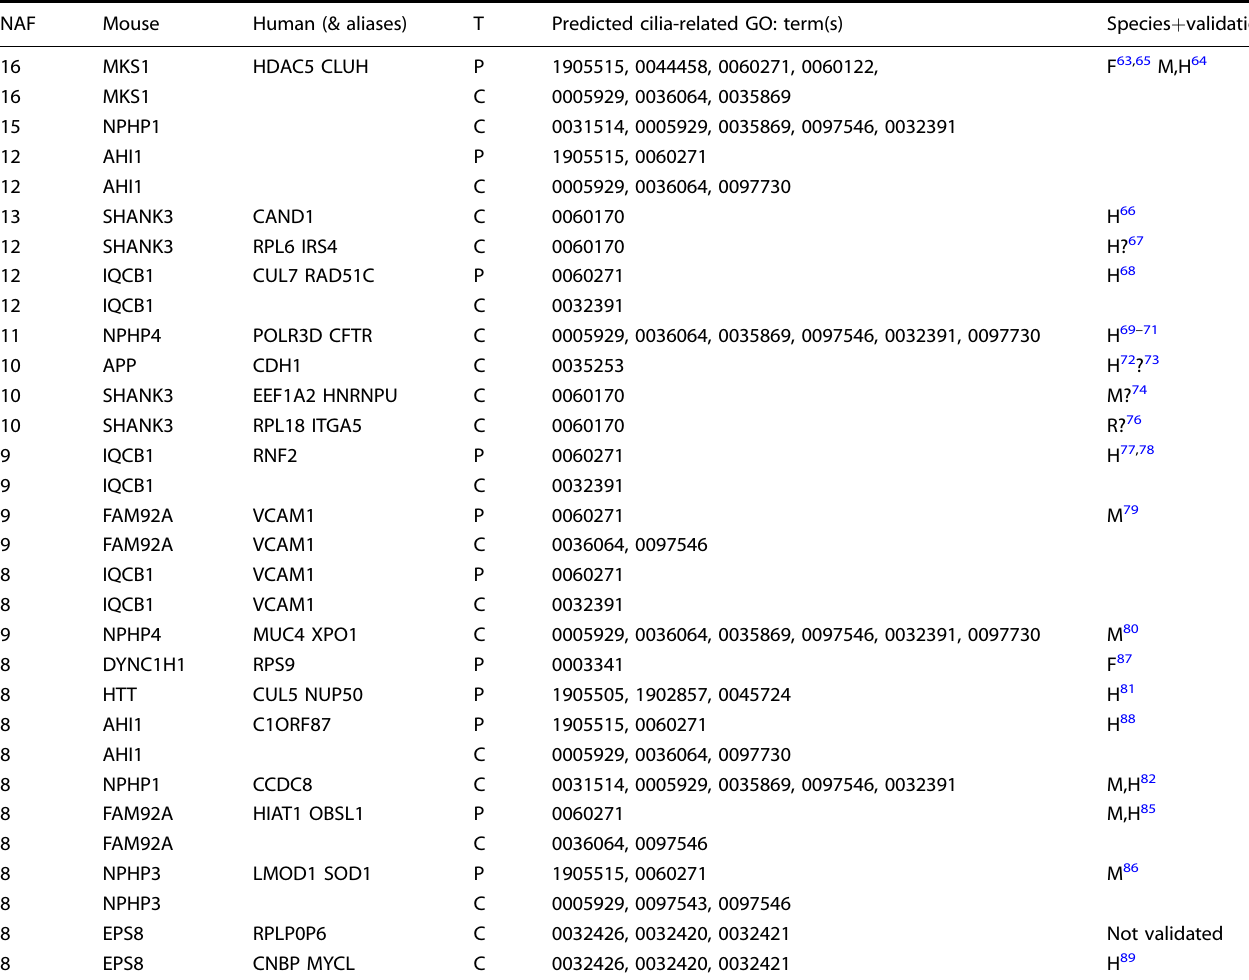
Table 5. All zero-sequence-similar cilia-related GO term predictions from BioGRID mouse to human with NAF 8% or greater: NAF is the network alignment frequency at which the Mouse protein was aligned to the Human